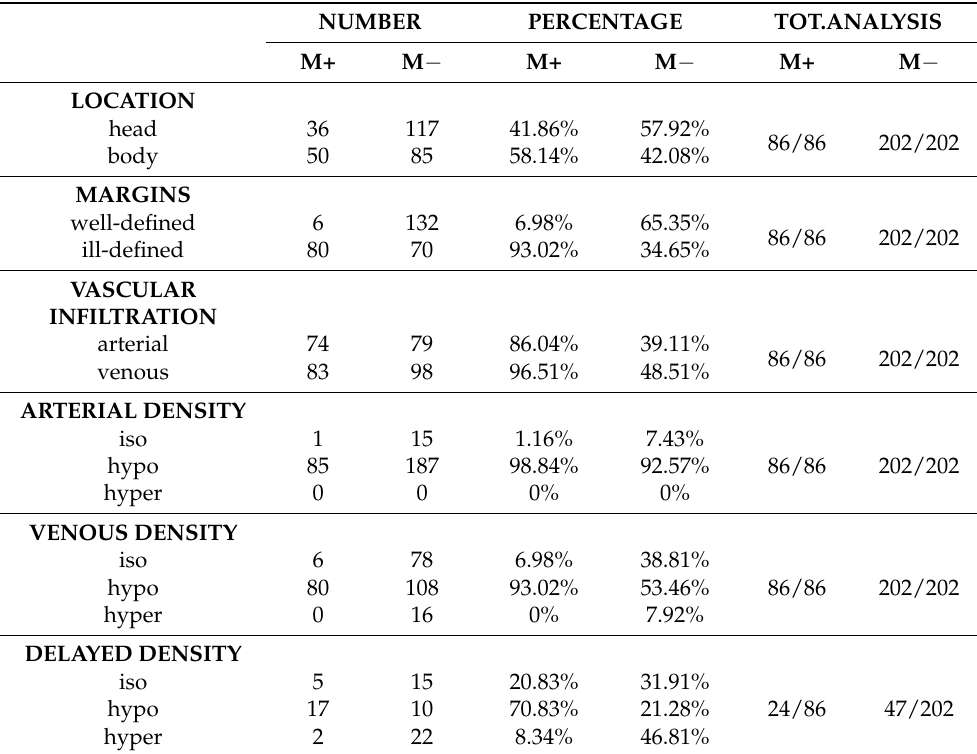
Table 1. Qualitative descriptors in metastatic (M+) and non-metastatic (M − )